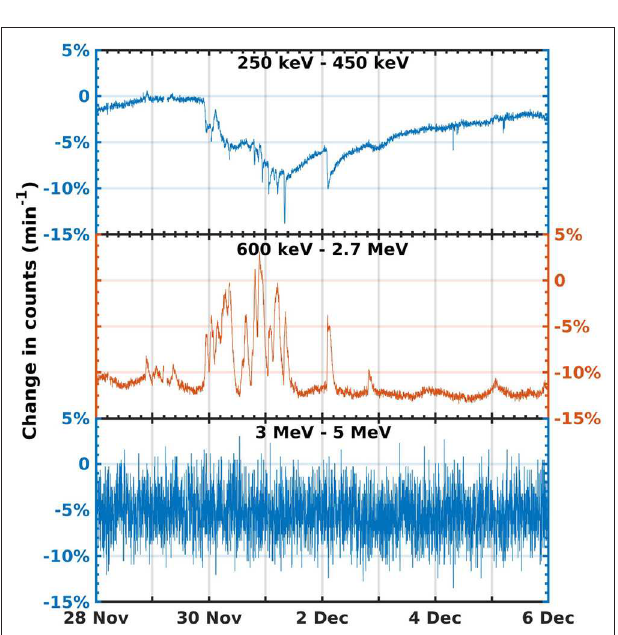
FIGURE 7 | The three important energy bands’ counts are represented separately. The decrease/increase is indicated in numbers on y-axes. 1st panel shows low-energy, 2nd panel shows mid-energy and the bottom panel shows the high-energy range trend during the Ockhi period.